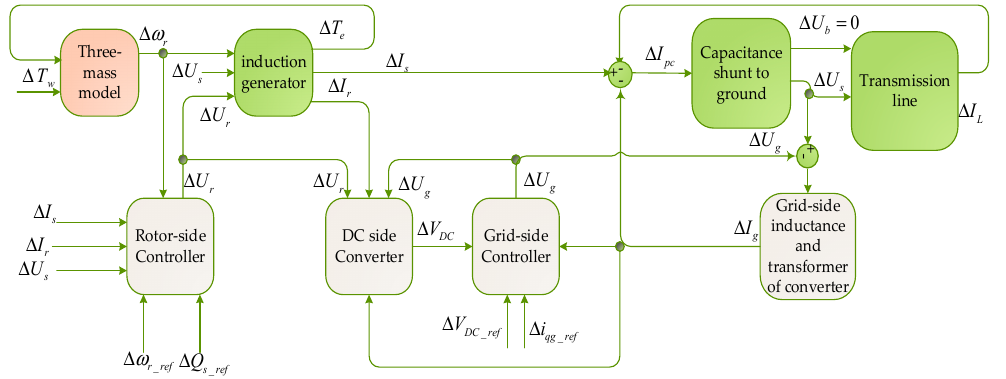
Figure 1. Based on the system structure above, the small-signal model of grid-connected DFIG is shown in Figure 2.